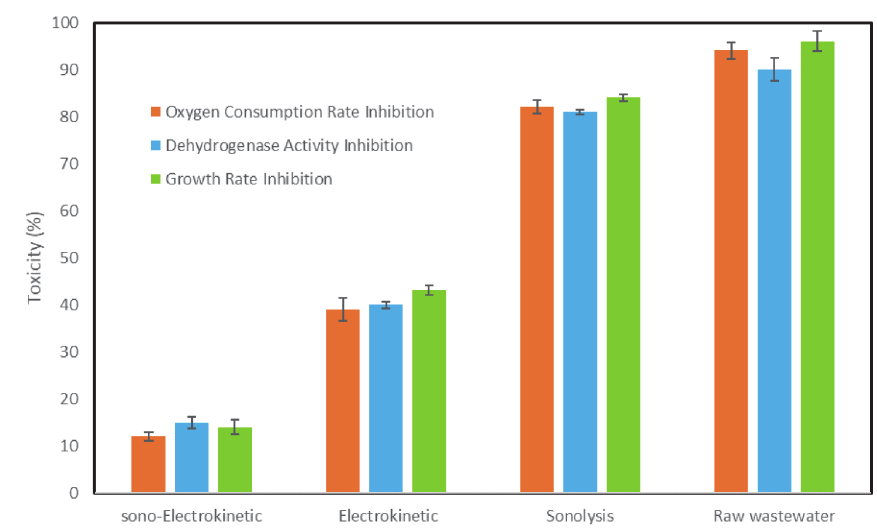
Fig. 6 – Results of toxicity assessment in different treatment alternatives, as well as in raw